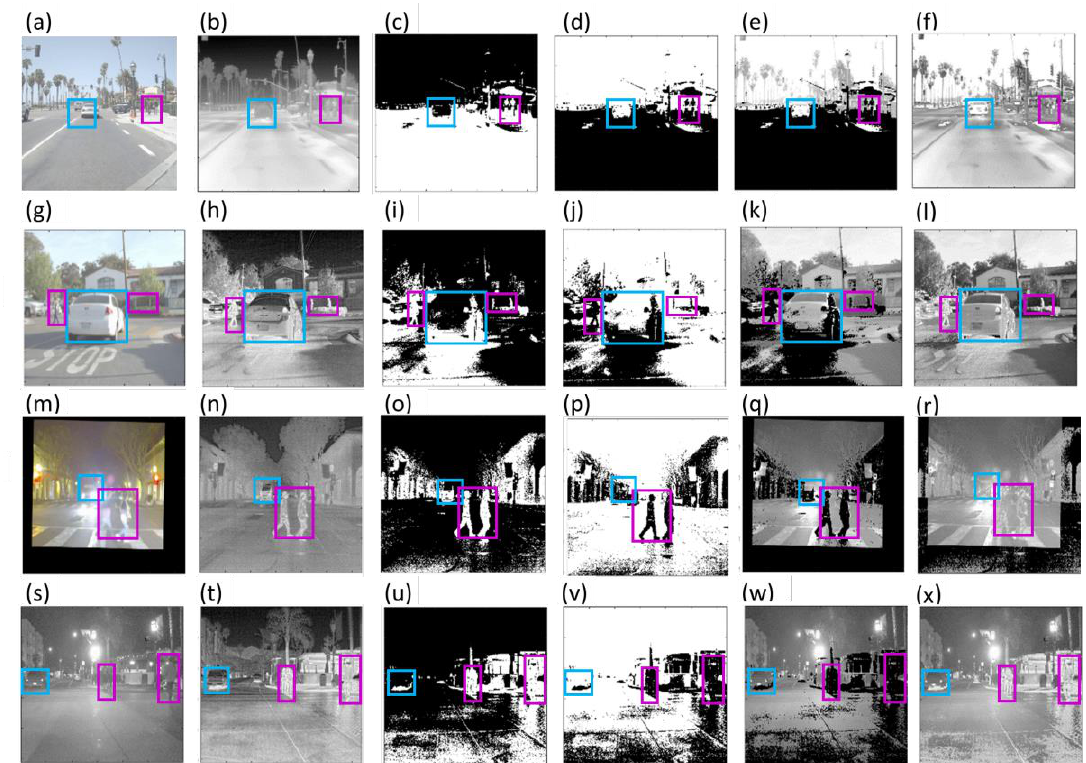
Figure 4. Rows: image samples from the test dataset. Daylight images: FLIR_02163 ( a – f ) and FLIR_05011 ( g – l ); Nightlight images: FLIR_05697 ( m – r ) and FLIR_08926 ( s – x ). Columns: registered RGB images ( a , g , m , s ); original IR image ( b , h , n , t ); a 0.7 threshold binary mask of the IR image ( c , i , o , u ); negative of the IR binary mask as background binary mask ( d , j , p , v ); masked registered RGB image as scene’s background ( e , k , q , w ); the fusion of masked RGB background and masked IR foreground ( f , l , r , x ). The blue bounding boxes were added to point out car objects, and magenta BBs were added to mark pedestrians.